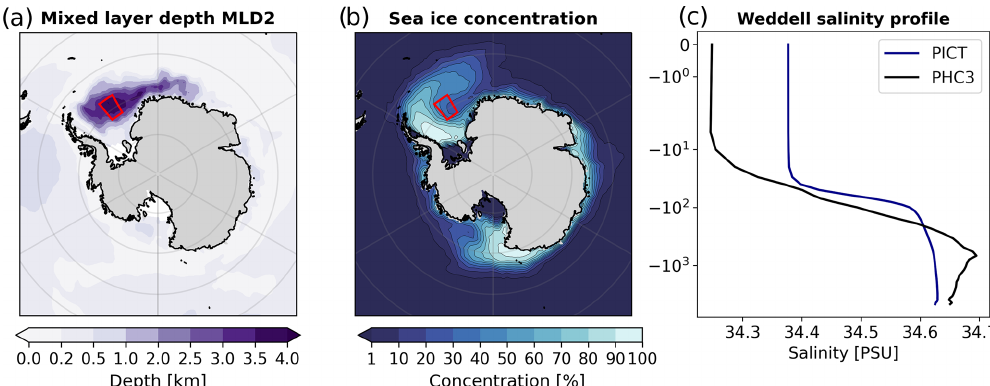
Figure 5. (a) Austral winter mean mixed-layer depth (MLD) where the potential density over depth differs by 0.125kgm − 3 from the surface density (Monterey and Levitus, 1997) averaged over the last 25 years of the PICT simulation. (b) High MLD values in the Weddell and Ross seas contribute to the persistent polynyas visible in the mean austral winter sea ice concentration over the same time period. (c) Salinity profile over the region marked in blue in comparison to PHC3 climatology (Steele et al.,